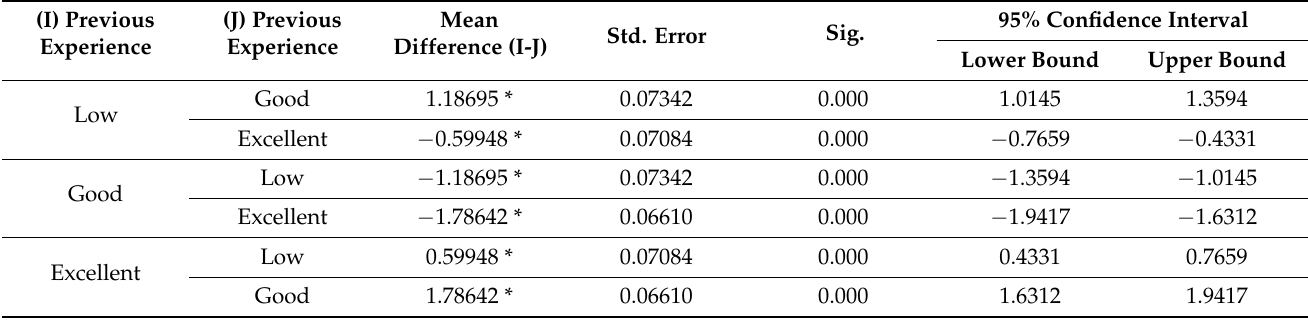
Table 12. Multiple comparisons analysis of the information adoption attributed to previous